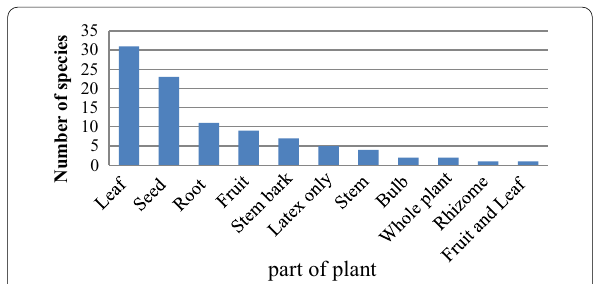
Fig. 2 Plant part used for preparation of human remedy